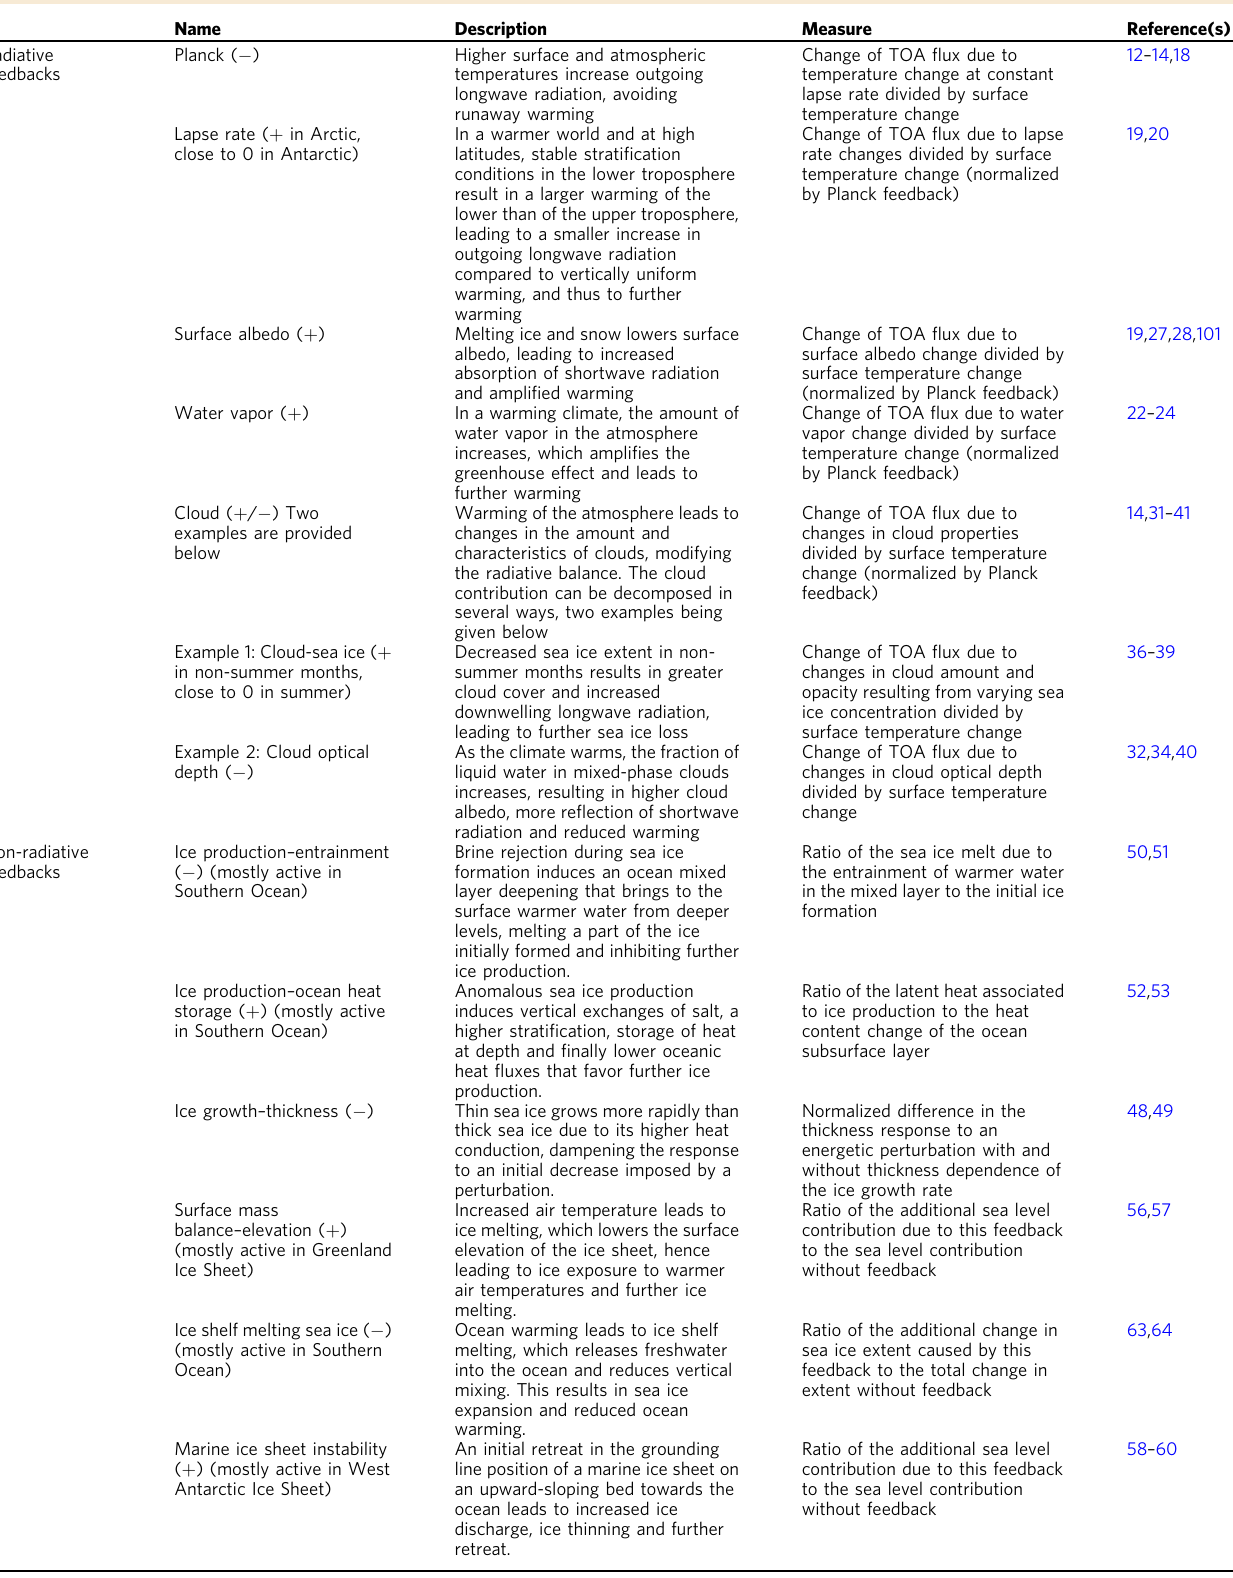
Table 1 Key radiative and non-radiative feedbacks in polar regions that are related to the atmosphere, ocean, sea ice, ice sheets and land surfaces and can be measured using a feedback